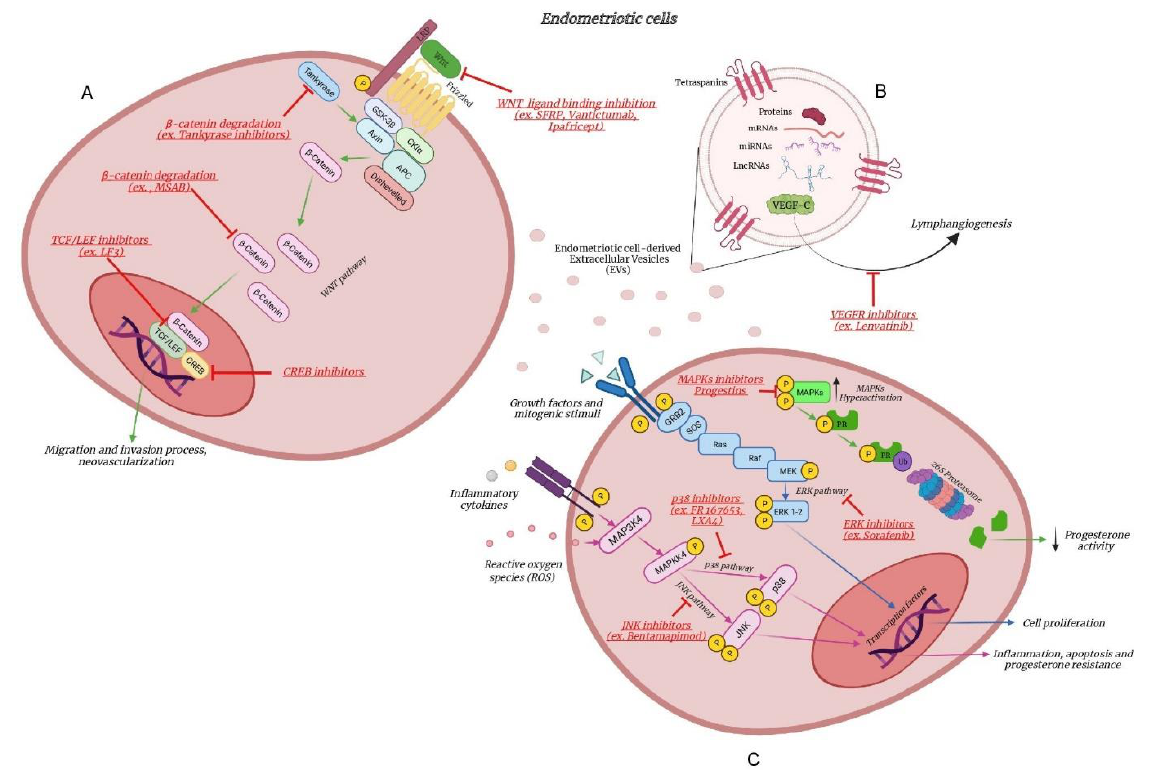
Figure 1. Schematic representation of the WNT pathway ( A ) and MAPK pathways ( B ) responsible for cell proliferation, migration, neovascularization, inflammation and progesterone resistance in endometriotic cells. Magnified representation of a VEGF-C-carrying extracellular vesicle (EVs) ( C ) involved in enhancing the lymphangiogenic capacity of lymphatic endothelial cells. Next-generation inhibitors that could be used to treat patients with endometriosis are shown in red and directed toward their specific therapeutic target. Created with BioRender.com.